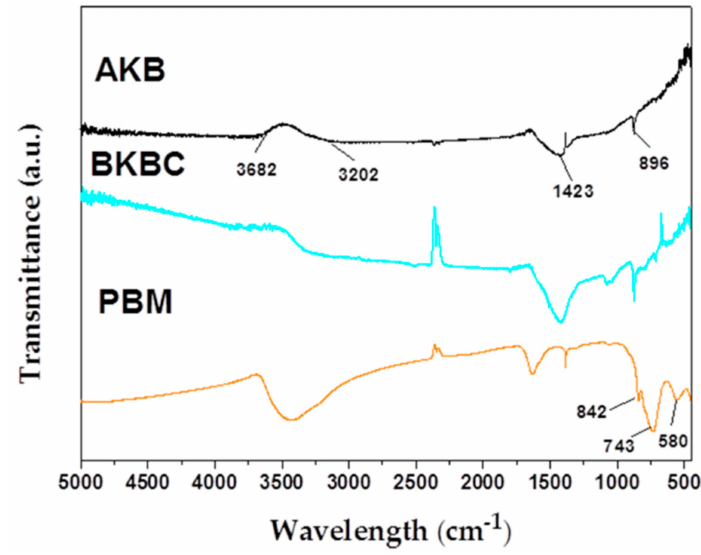
Figure 4. FT-IR spectra of AKB, BKBC, and